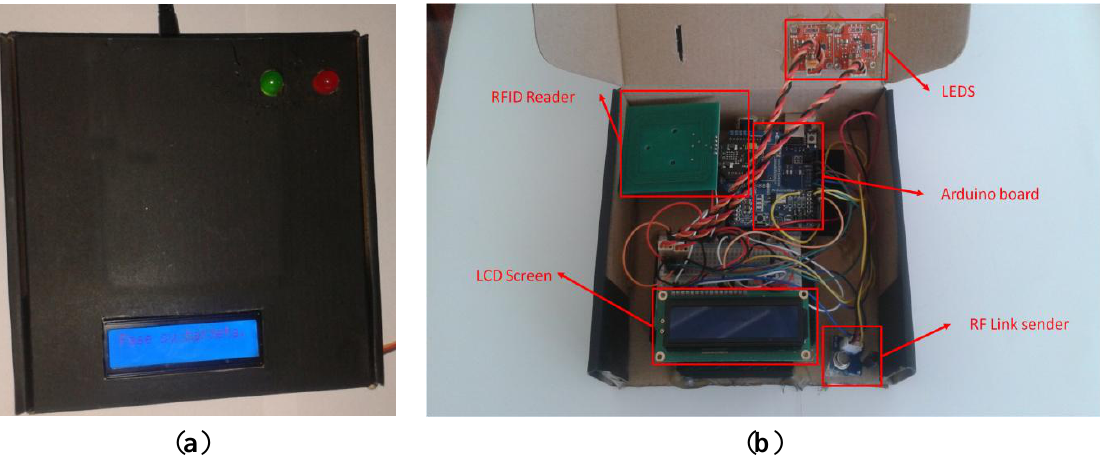
Figure 4. Classroom node hardware prototype: ( a ) outside ( b )